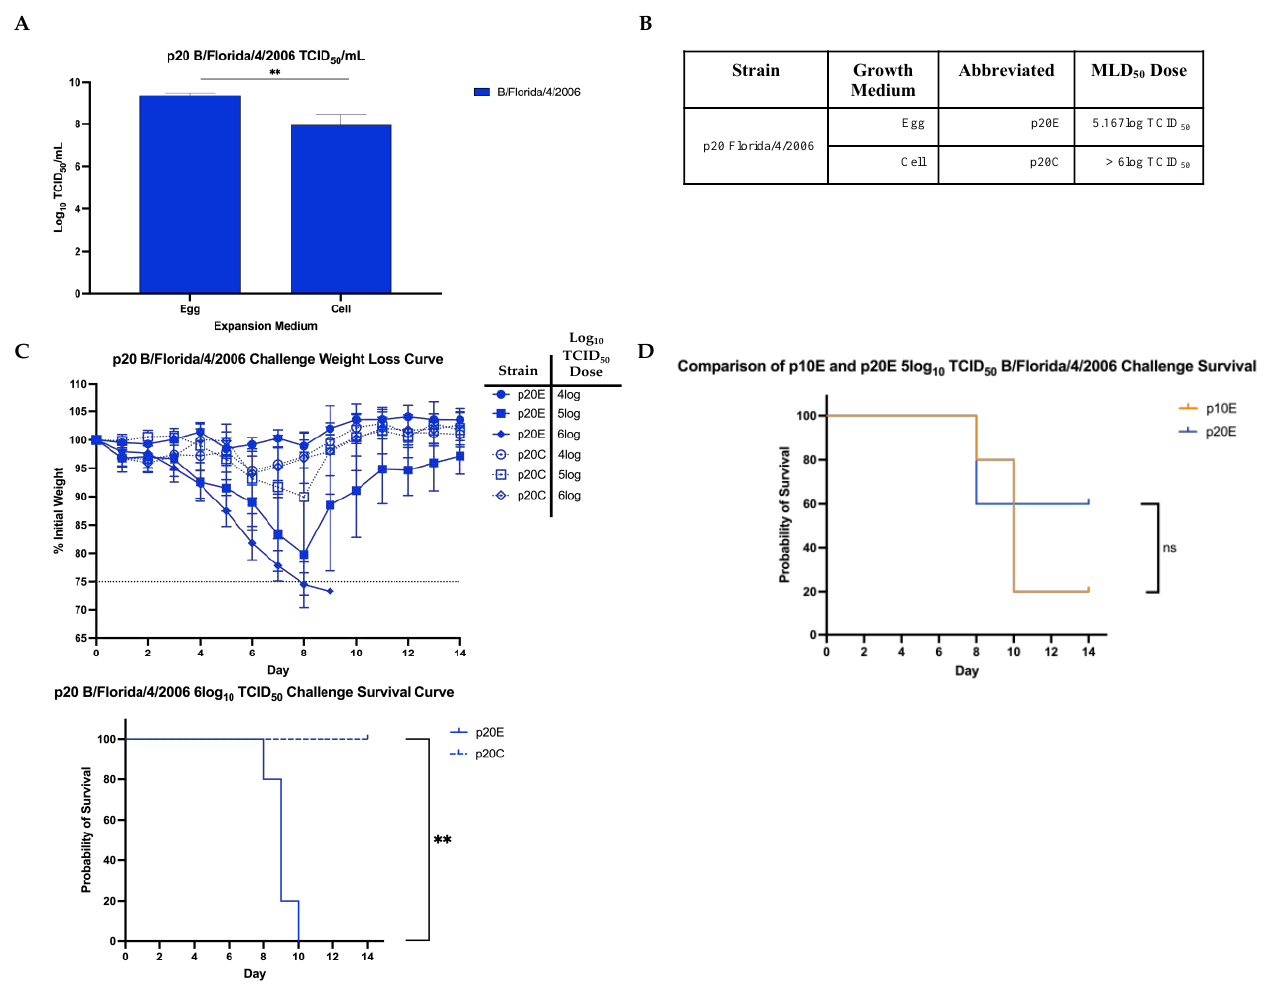
Figure 4. Pathogenicity of FL/4/06 after 20 total lung-lung passages. ( A ) TCID 50 /mL titers of FL/4/06 p20E and p20C. ( B ) Table breaking down MLD 50 values calculated using the Reed – Meunch method (31) for FL/4/06 p20E and p20C. ( C ) Mice challenged with doses corresponding to logTCID 50 of FL/4/06 p20E or p20C were followed for 14 d.p.i. for weight loss (top) and survival after challenge with 6log TCID 50 units (bottom). A ≥25% initial weight lost was used as a threshold for humane sacrifice of the animals. ( D ) Comparison of survival probability of mice challenged with 5log TCID 50 of p10E or p20E. No statistically significant difference in survival probability was observed. Statistical differences in TCID 50 /mL titers were calculated using unpaired t-tests, while statistical significance between group survival was calculated through log-rank Mantel – Cox test. Statistical analysis was performed in GraphPad Prism 9.0 ** p < 0.01).